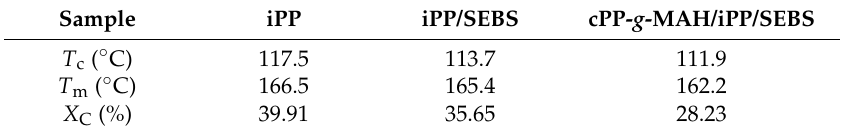
Figure 3. Differential scanning calorimetry (DSC) temperature spectra in melting ( a ) and crystallization ( b ) processes for different samples. Table 3. Thermal parameters from differential scanning calorimetry (DSC) test for different samples.